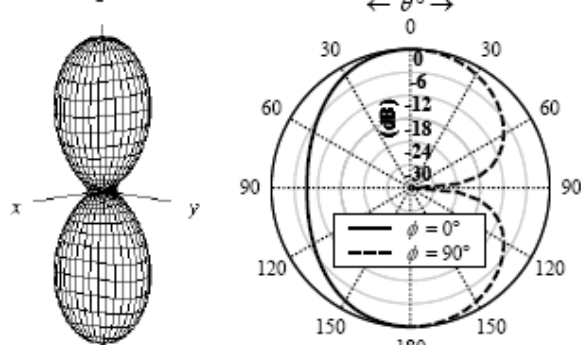
= 13.2 mm, b = 16.1 -2 -1